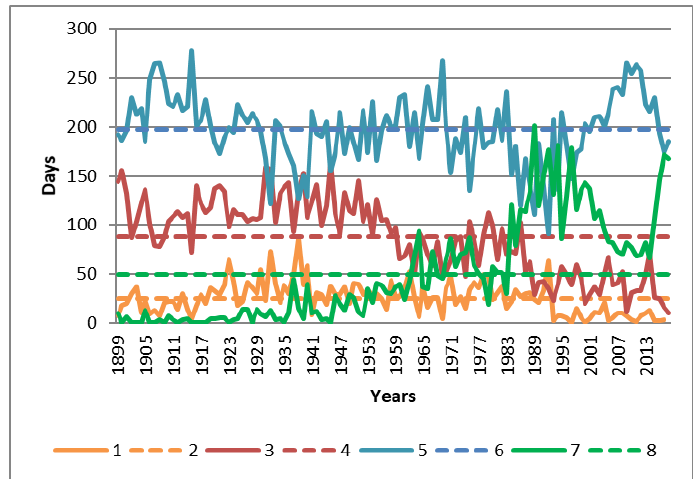
Figure 2. The annual total duration (days) of the global atmospheric circulation types from 1899 to 2018 for Type 1 (1. orange solid), Type 2 (3. red solid), Type 3 (5. blue solid), Type 4 (7. green solid), respectively, and their 1899-2018 mean for Type 1 (2. orange dashed), Type 2 (4. red dashed), Type 3 (6. Blue dashed), Type 4 (8. green dashed), respectively.